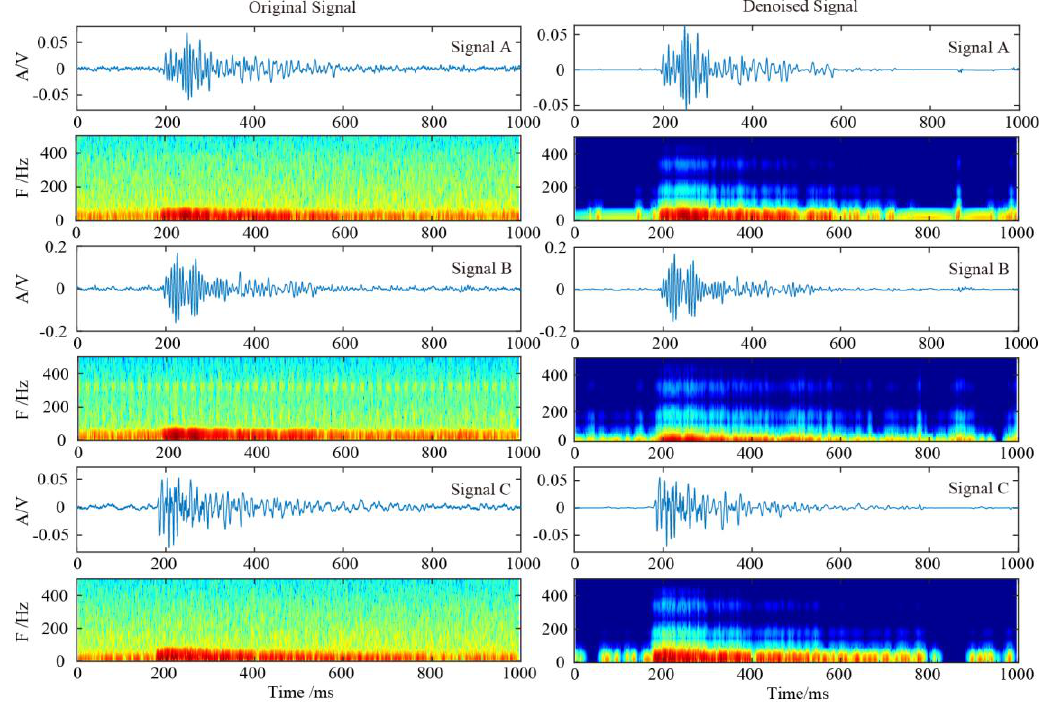
Figure11. ThewaveformbeforeandafterdenoisingoftheMSsignal, Figure 11. The waveform before and after denoising of the MS signal, and their time-frequency spectrum.